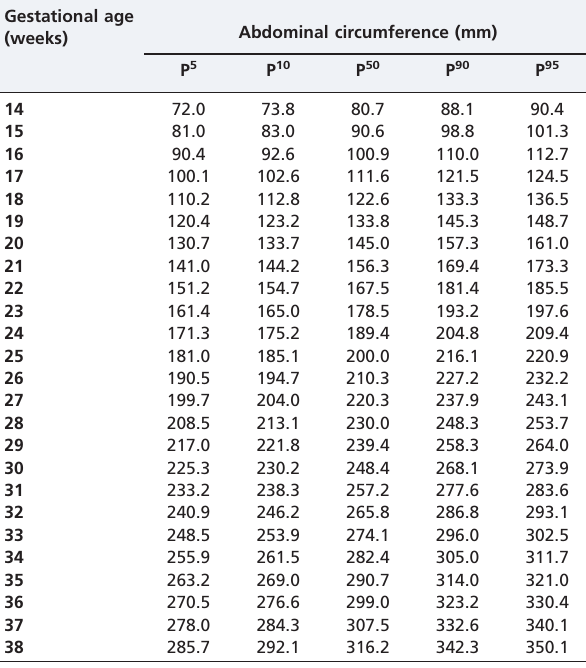
Table 4 - Longitudinal reference ranges for abdominal circumference based on 807 ultrasound examinations performed on 250 fetuses from 125 uncomplicated, twin pregnancies.